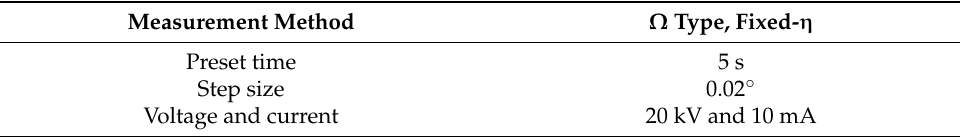
Table 3. XRD conditions for analyzing phase compositions of T15K6.